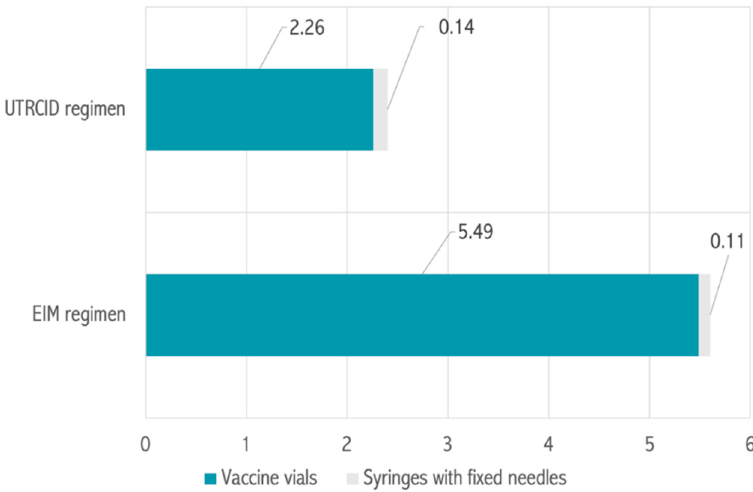
Figure 3. Cost per person for rabies vaccination via the Essen intramuscular (EIM) regimen and updated Thai Red Cross intradermal (UTRCID) regimen. Costs are expressed in USD.